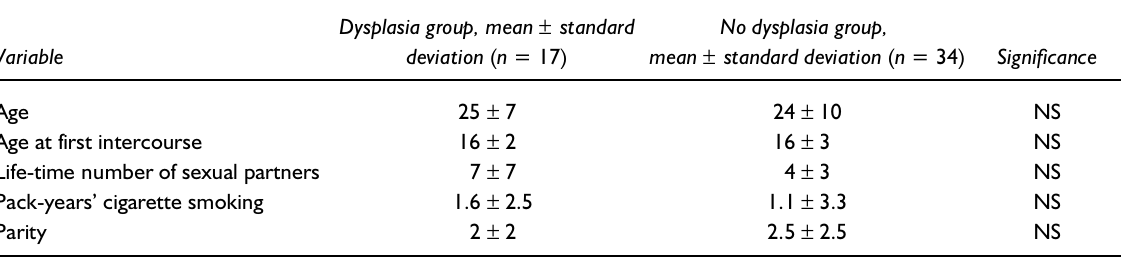
Table 1 Comparison of continuous variables between dysplasia and no dysplasia groups